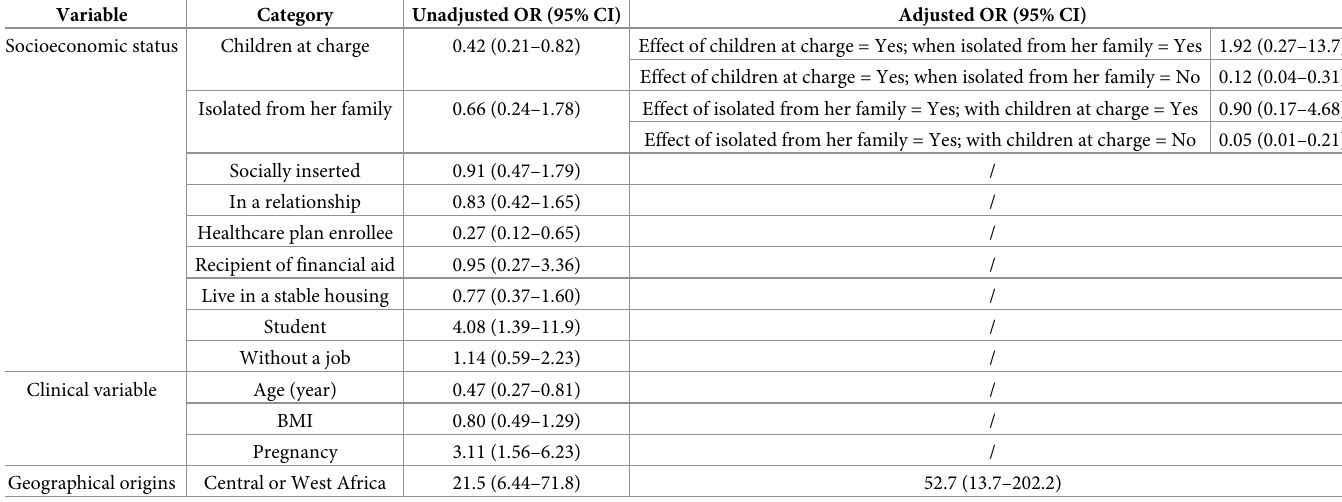
Table 5. Factors independently associated with kaolin